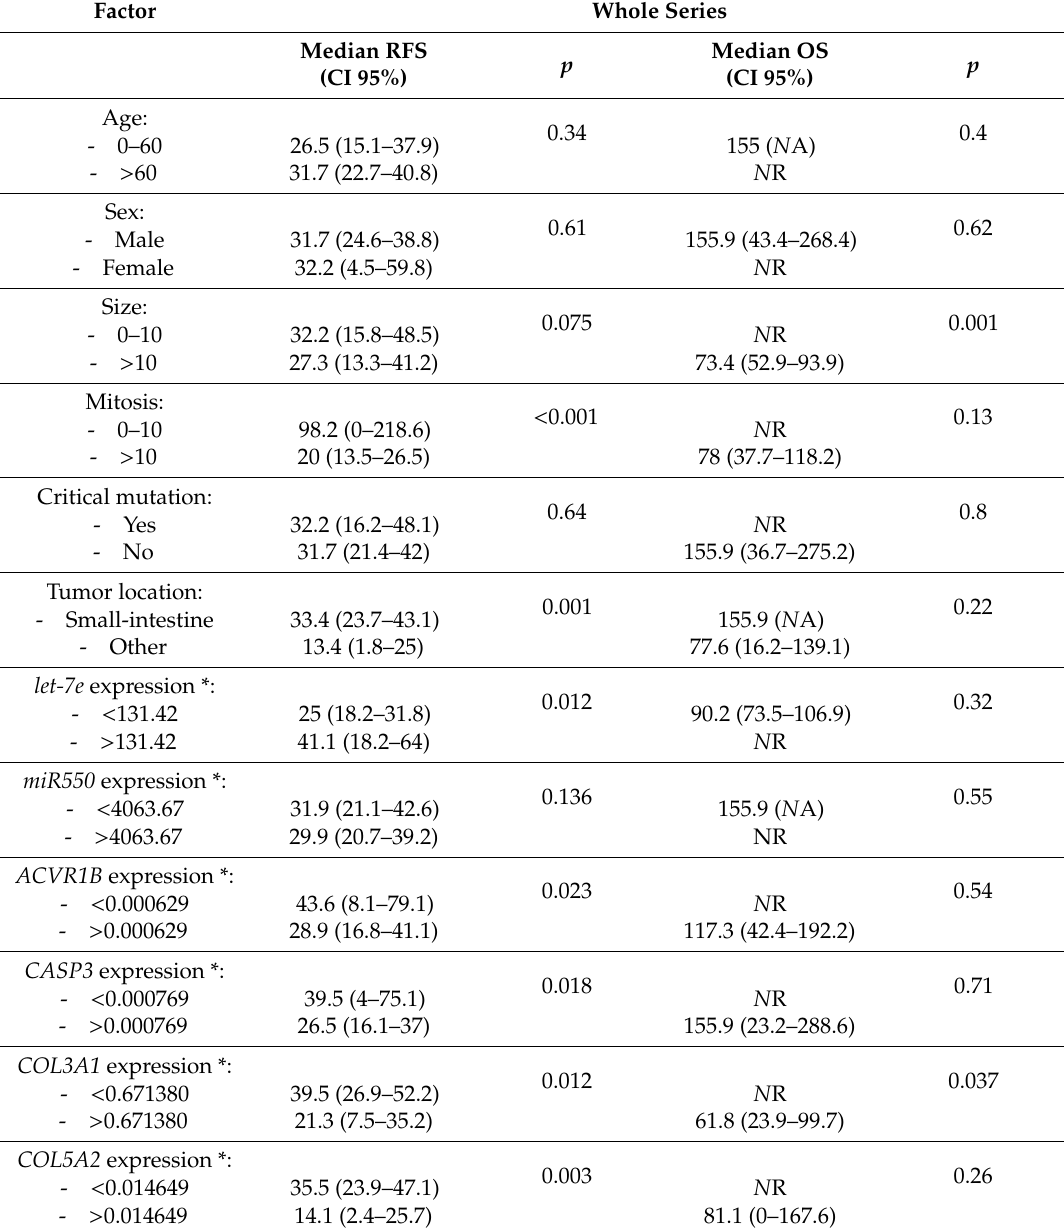
Table 2. Univariate